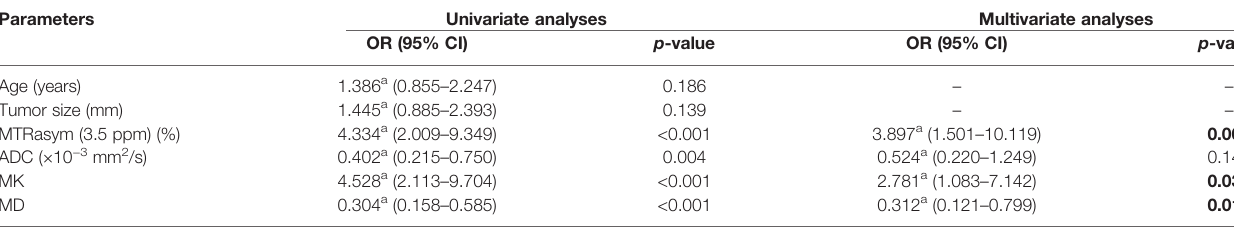
TABLE 5 | Univariate and multivariate analyses for the identi fi cation of low- and non-low-risk EC patients. Parameters Univariate